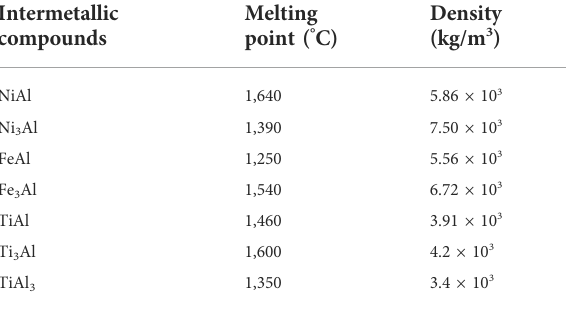
TABLE 1 Properties of some intermetallics (Cinca and Guilemany, 2012).